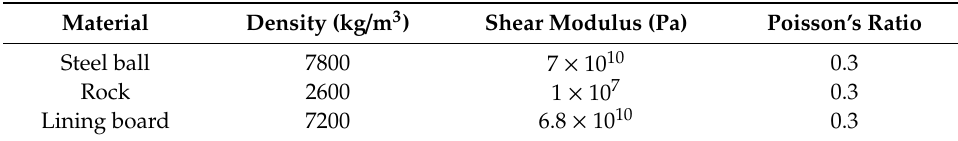
Table 3. Material properties parameters.